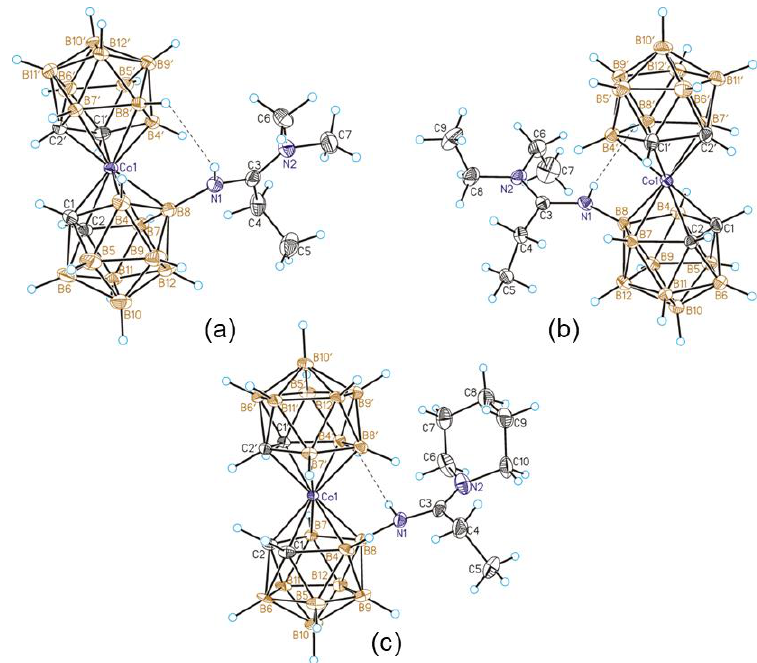
Figure 3. ( a ) The crystal molecular structures of E -[8-EtC(NMe 2 )=HN-3,3′-Co(1,2-C 2 B 9 H 10 )(1′,2′-C 2 B 9 H 11 )] ( 7 ); ( b ) E -[8-EtC(NEt 2 )=HN-3,3′-Co(1,2-C 2 B 9 H 10 )(1′,2′-C 2 B 9 H 11 )] ( 8 ) and ( c ) E -[8-EtC(NС 5 H 10 )=HN-3,3′-Co(1,2-C 2 B 9 H 10 )(1′,2′-C 2 B 9 H 11 )] ( 9 ).